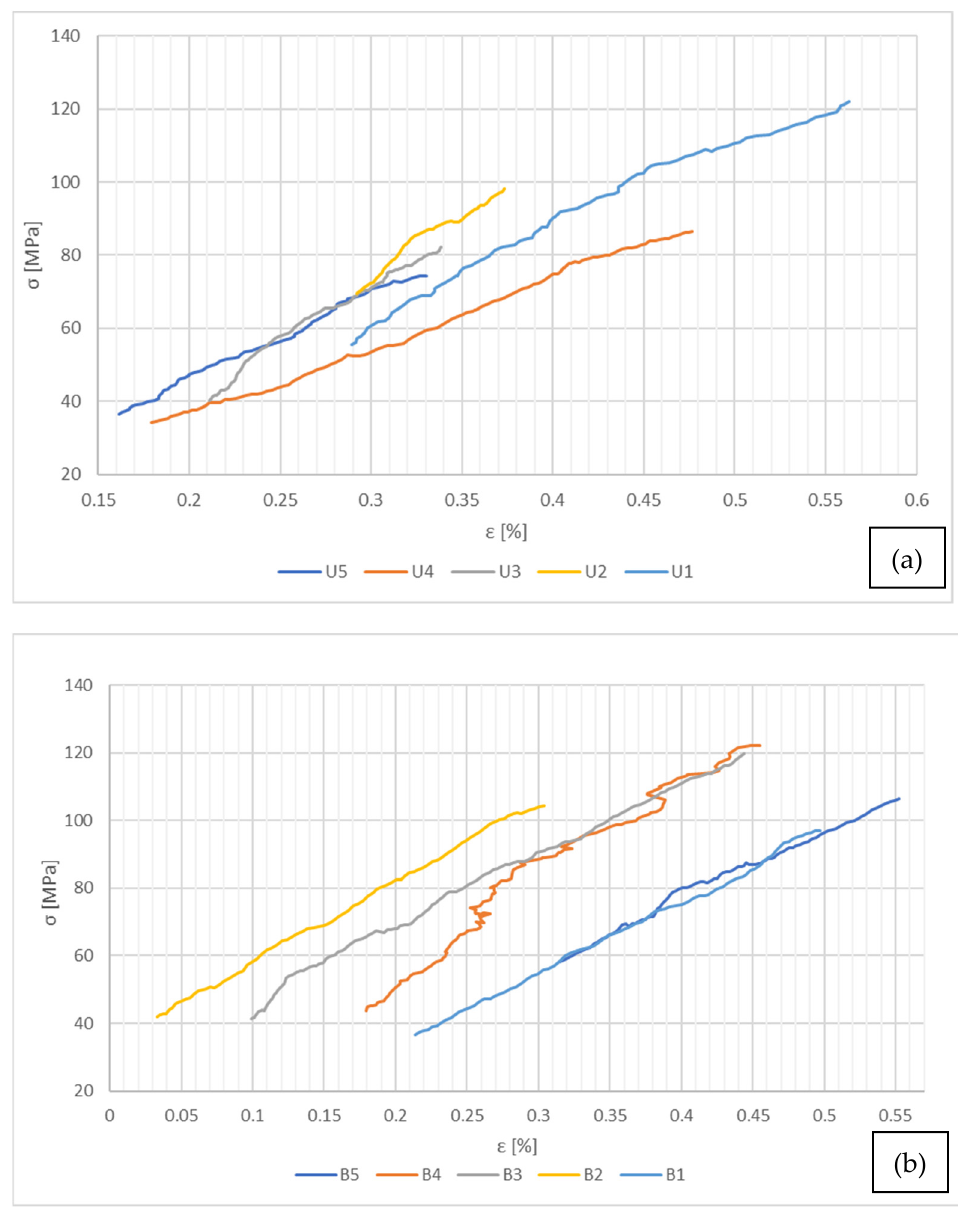
Figure 6. Linear elastic variation for the single-ply test specimens—( a ) warp cut specimens, ( b ) weft cut test specimens.